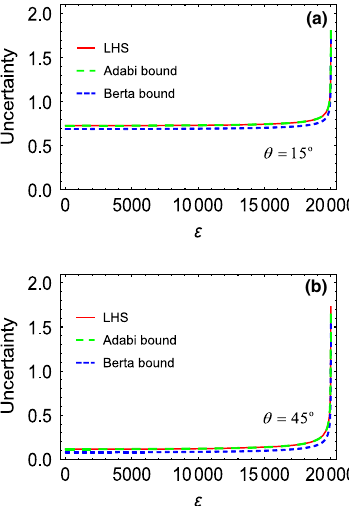
Fig. 5 The LHS, Adabi bound, and Berta bound with respect to the volume expansion ε when considering two complementary observables (σ ,σ ) . σ = 2, (cid:14) = 2, μ x z